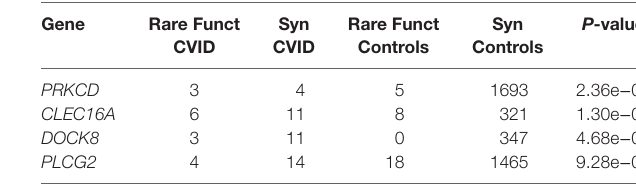
TaBle 8 | Excess of rare functional variants in common variable immunodeficiency (CVID) patients.